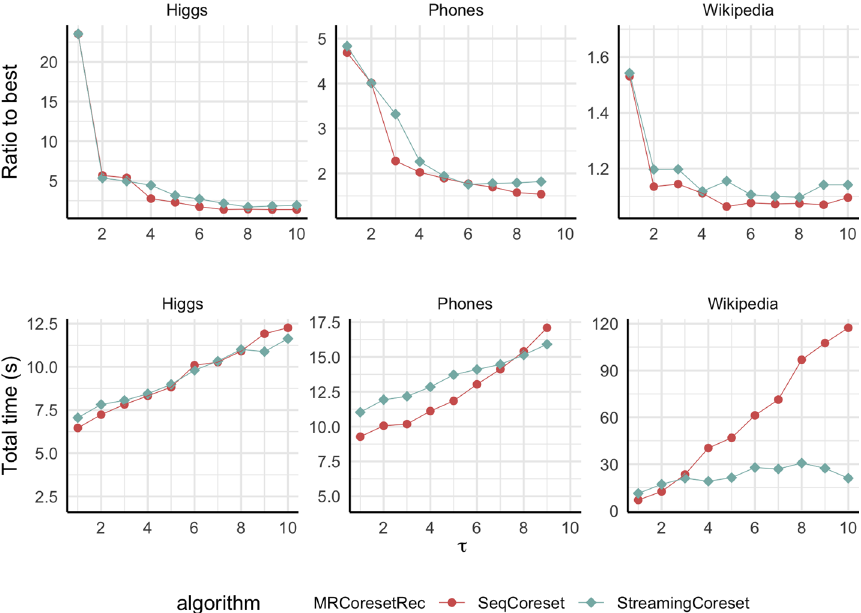
Fig. 1 Effect of the parameter τ on the solution quality (top) and the running time (bottom) for S eq C oreSet and S treaming C